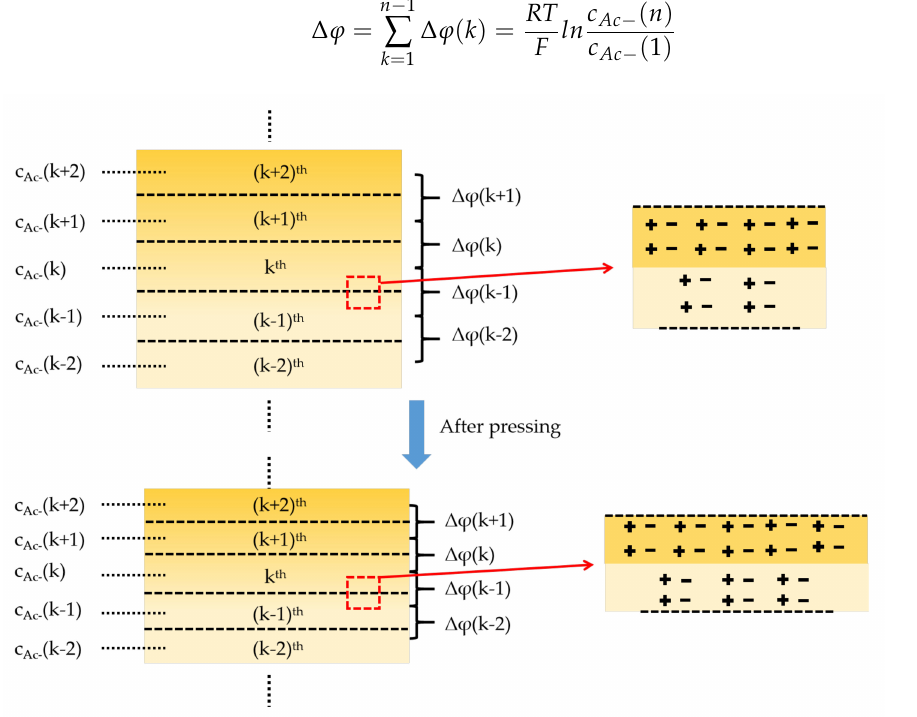
Figure 4. Schematic diagram of pressure and sensing mechanism of self-powered gradient